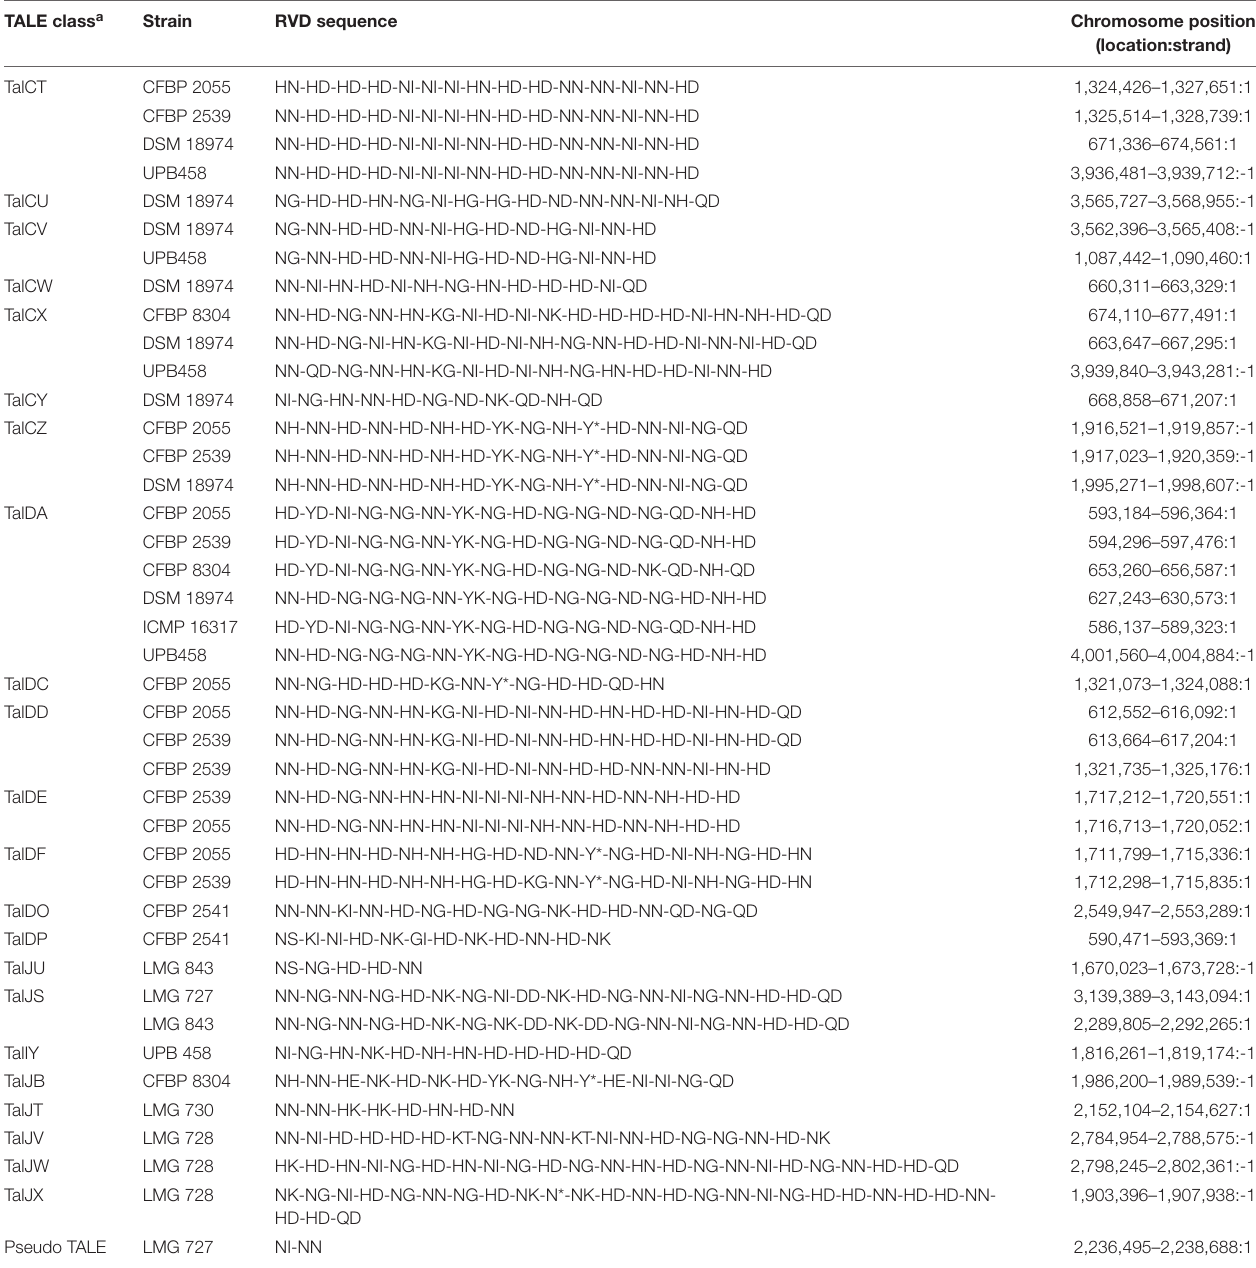
TABLE 2 | Classes and repeat variable diresidue (RVD) sequences of transcription activator-like effectors (TALEs) found in the X. translucens pathotype strains. TALE class a Strain RVD sequence Chromosome position